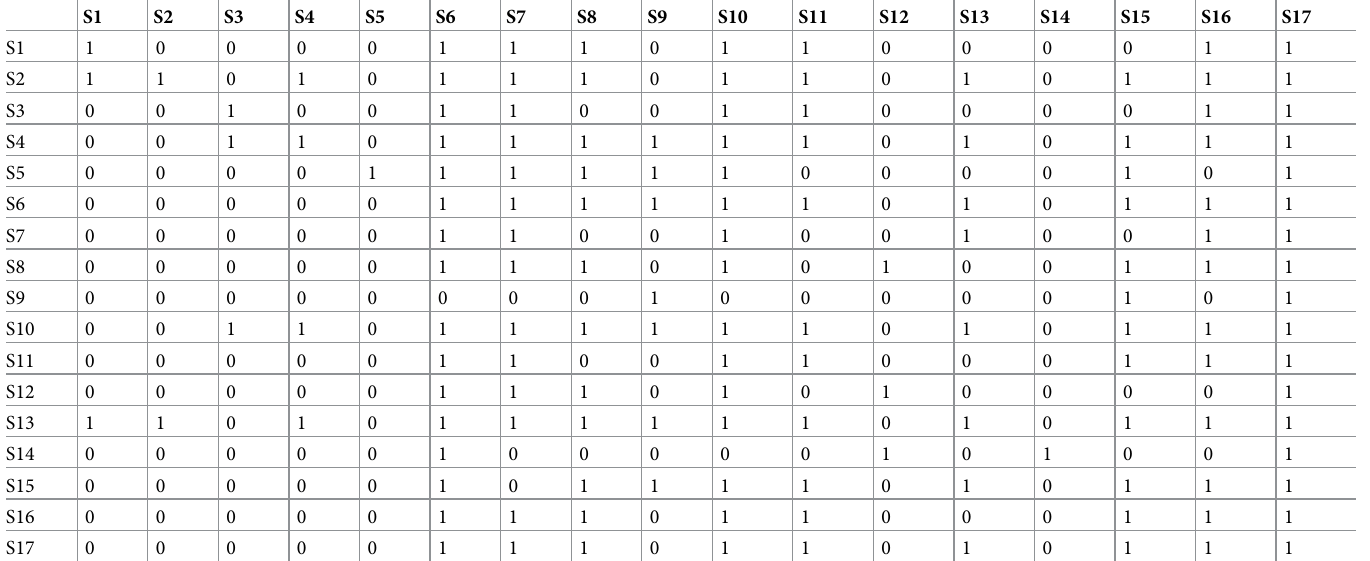
Table 11. The reachability matrix